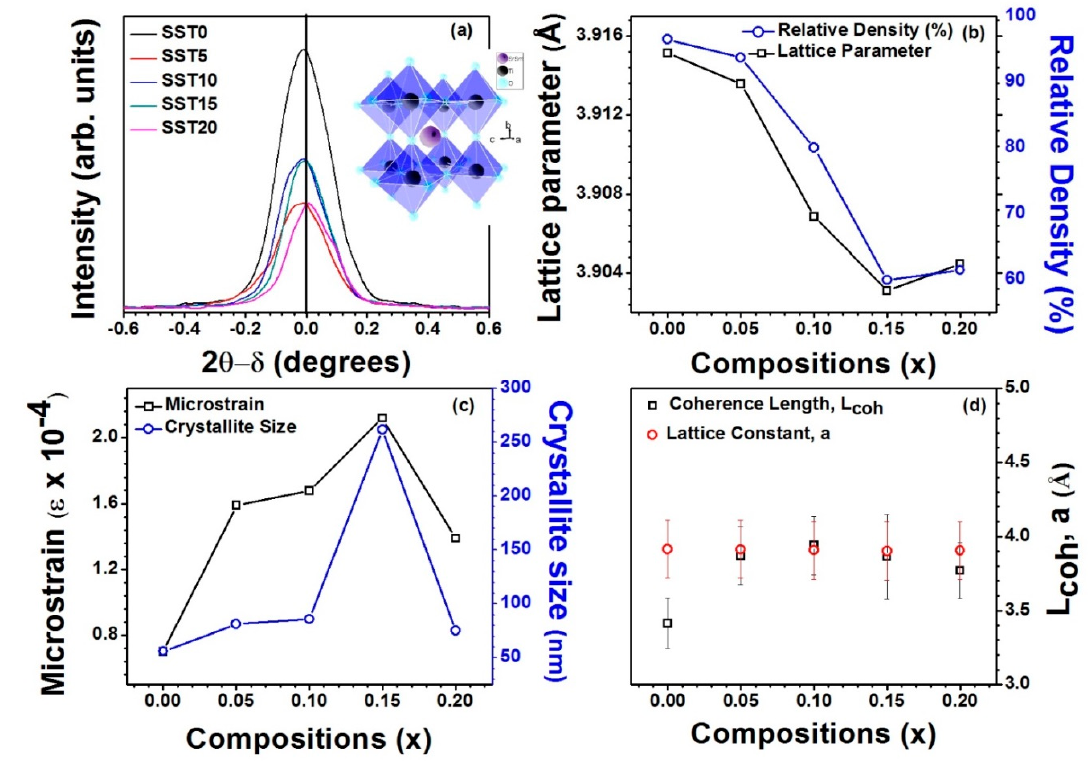
Figure 3. ( a ) Variation of intensity of XRD peak with 2 θ - δ ( ◦ ) where δ is the angle at which maxima occurs showing diffuseness of the XRD peak (110) with the compositions; ( b ) the variation of the lattice parameters and relative density with the compositions; ( c ) the variation of the microstrain and crystallite size with the compositions; and ( d ) the variation of the coherence length of the polarons (L coh ) with the lattice parameters.